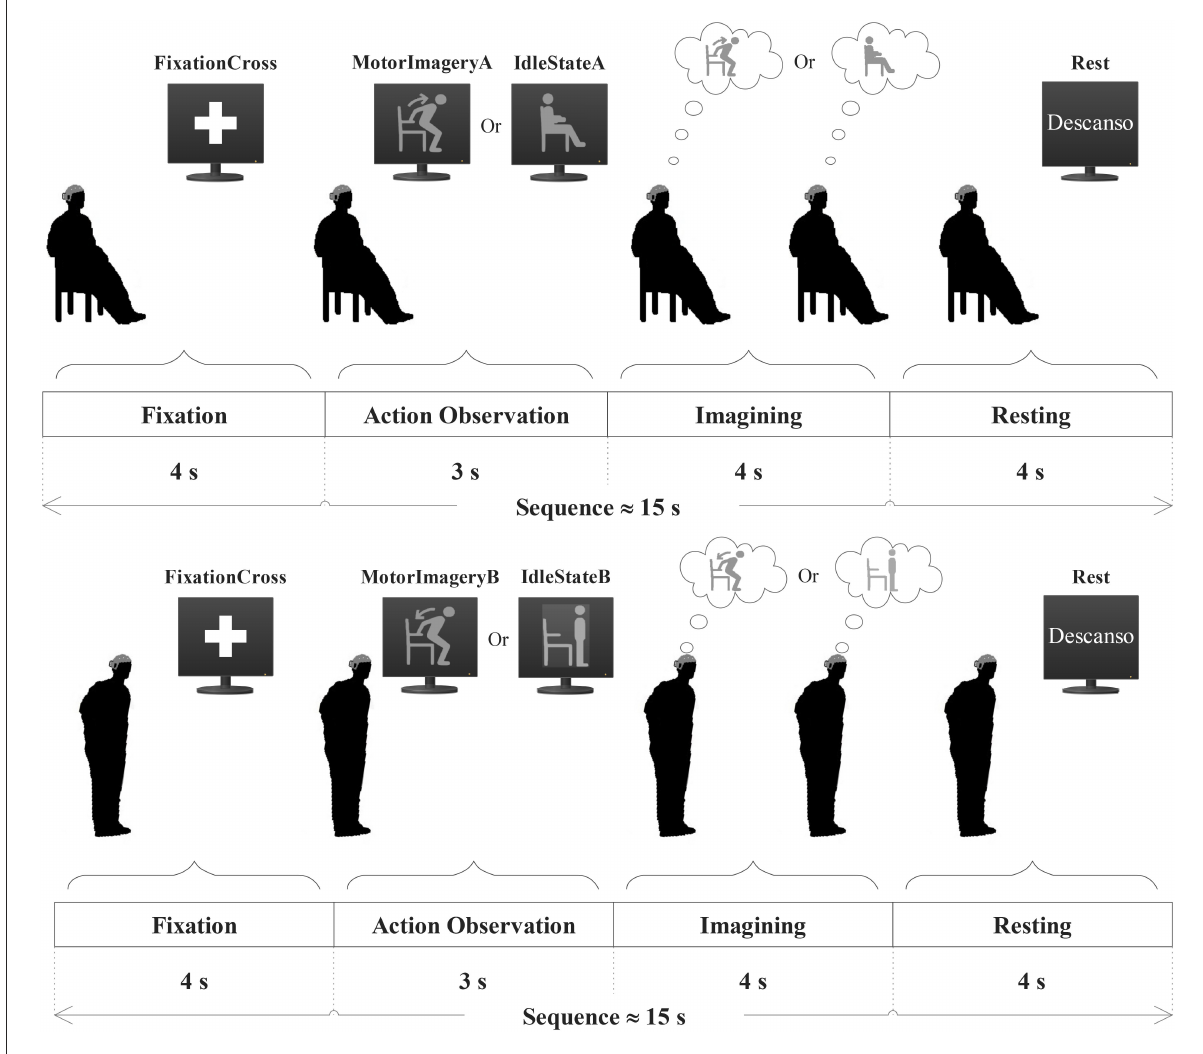
FIGURE2 Illustration of the temporal sequence of a trial performed by the participant in the sit-to-stand experiment (Top) and in the stand-to-sit experiment (Bottom) . Each sequence consisted of four steps: fixation, action observation, imagining, and resting.